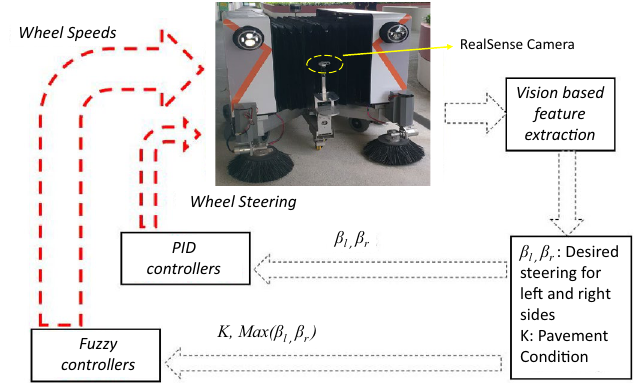
Figure 6. Controller architecture.